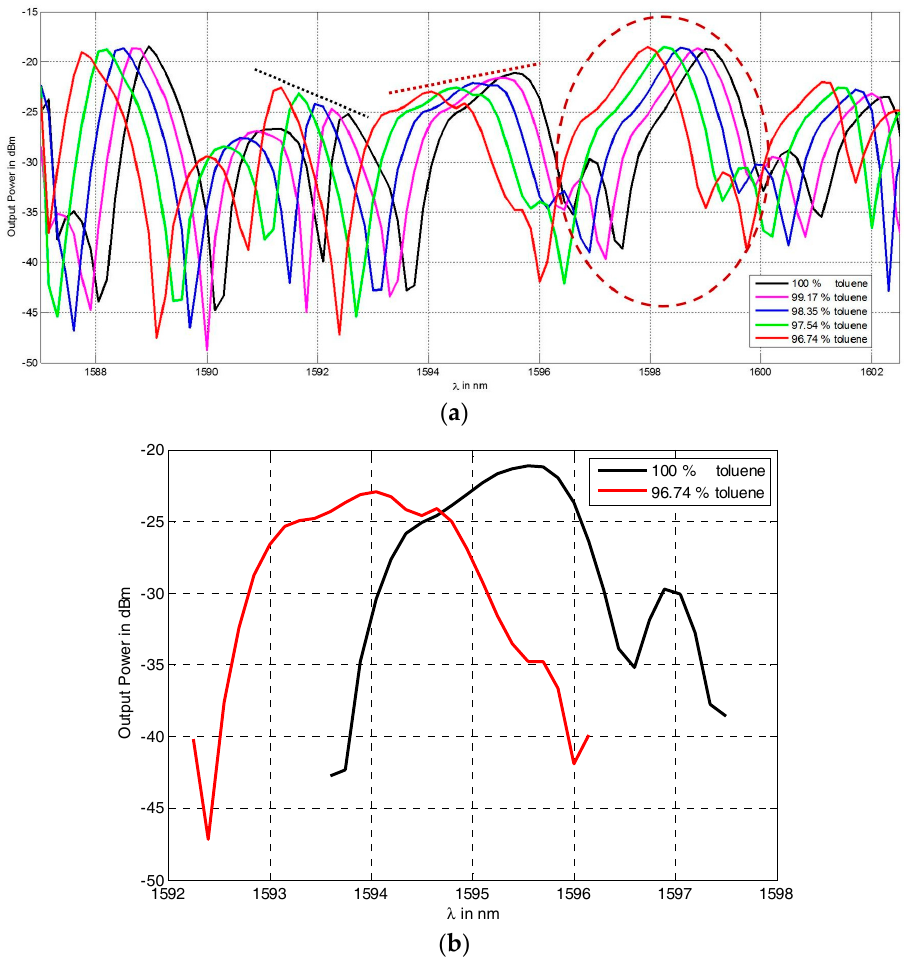
Figure 9. ( a ) The spectra of different mixture ratios of toluene and acetone measured by the proposed refractometry device. The peaks surrounded by the red dashed circle have the same maximum power transmission values, despite the different mixing ratios of toluene and acetone. ( b ) Zoom around the wavelength 1595 nm of the spectra of the two extreme mixing cases to indicate that the decrease in the transmitted power level upon changing the RI is due to the modal interference between the main peak and that of the higher order mode.